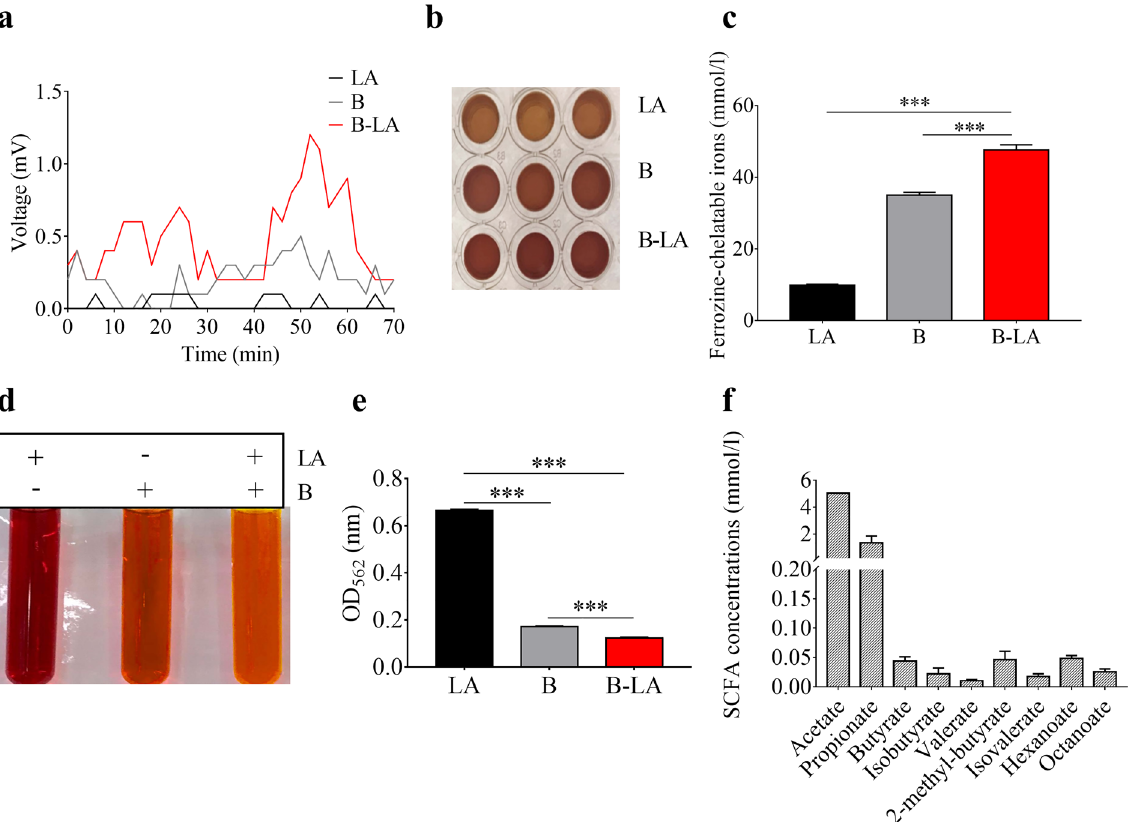
Figure 1. Characterization of electricity produced by L. mesenteroides EH-1 bacteria in the presence of linoleic acid. ( a) Chronoamperometry results were obtained from an electrochemical chamber with L. mesenteroides EH-1 bacteria alone (B), 2% linoleic acid (LA), bacteria plus linoleic acid (B-LA). The changes in voltage (mV) against time (min) were recorded by Lutron software. (b) Ferrozine and ferric ammonium citrate were added into media with linoleic acid (LA), L. mesenteroides EH-1 bacteria (B), bacteria plus linoleic acid (B-LA). The dark brown complexes of ferrozine-chelatable irons (mmol/l) were photographed. ( c ) The OD 562 values of ferrozine-chelatable irons (mmol/l) were quantified. ( d ) Linoleic acid fermentation of L. mesenteroides EH-1. L. mesenteroides EH-1 (B) was incubated in rich media with/without linoleic acid (LA) for 24 h. Rich media plus linoleic acid (LA) without L. mesenteroides EH-1 were included as controls. ( e ) Fermentation was detected by OD 562 . ( f ) The concentrations of nine SCFAs were detected by GC–MS analysis. Data shown represent the mean ± SD of experiments performed in triplicate. *** p < 0.001 (two-tailed t -test by GraphPad Prism